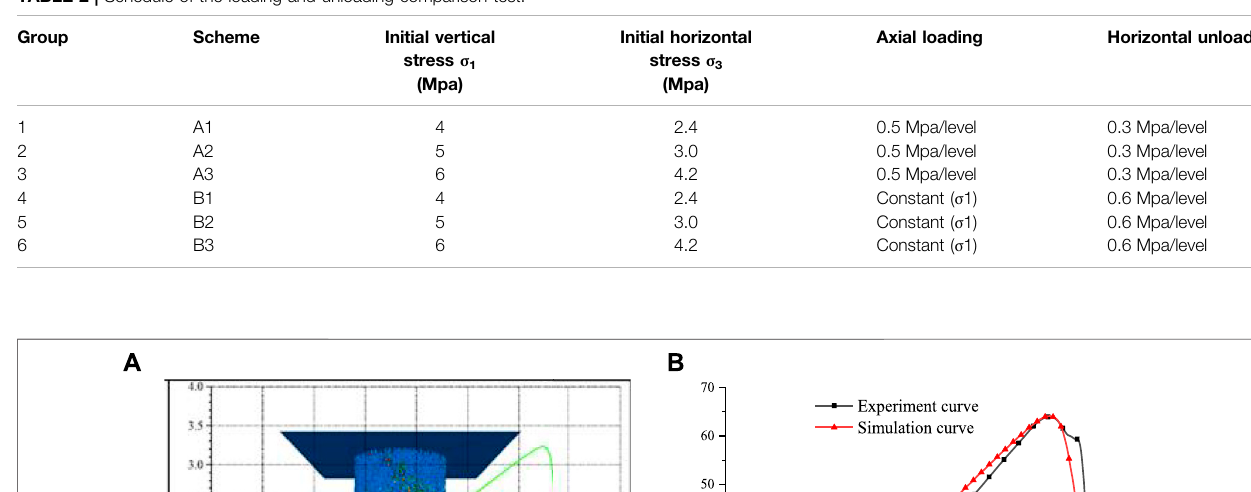
TABLE 2 | Schedule of the loading and unloading comparison test.